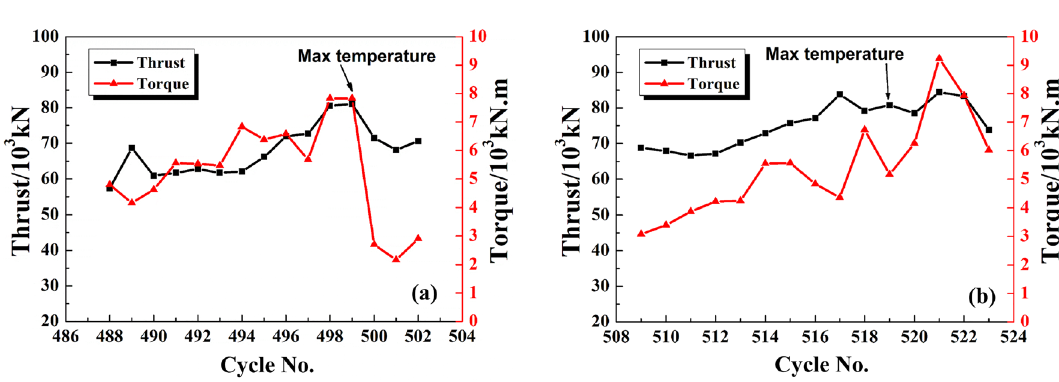
Figure 14. Temperature maximum of P1: ( a ) first, ( b ) second.